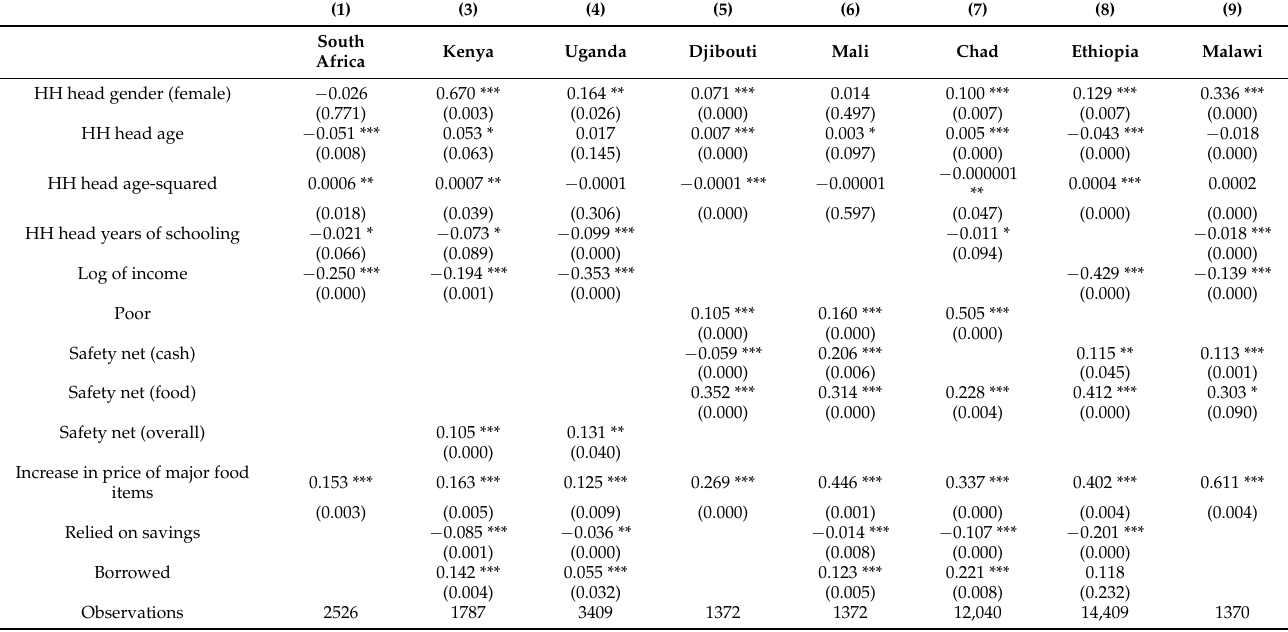
Table A4. Determinants of food insecurity—went